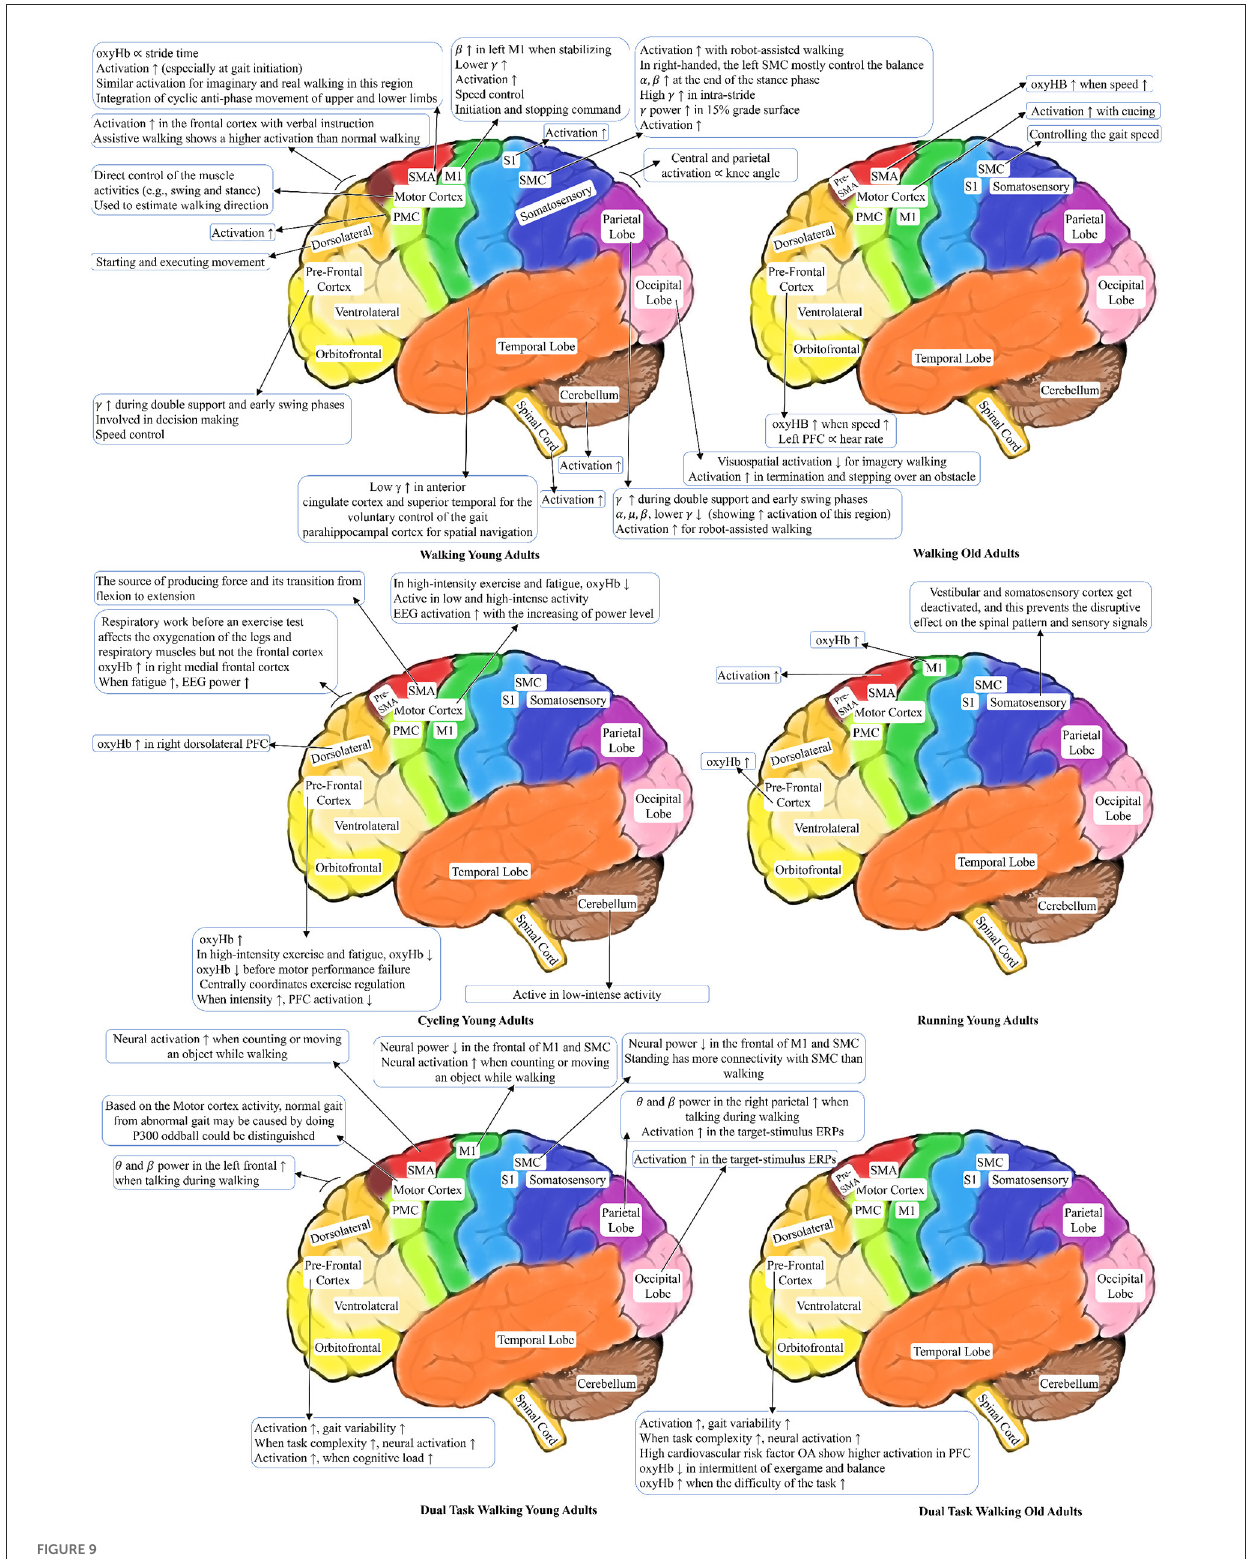
FIGURE9 Brain areas activation patterns during locomotion